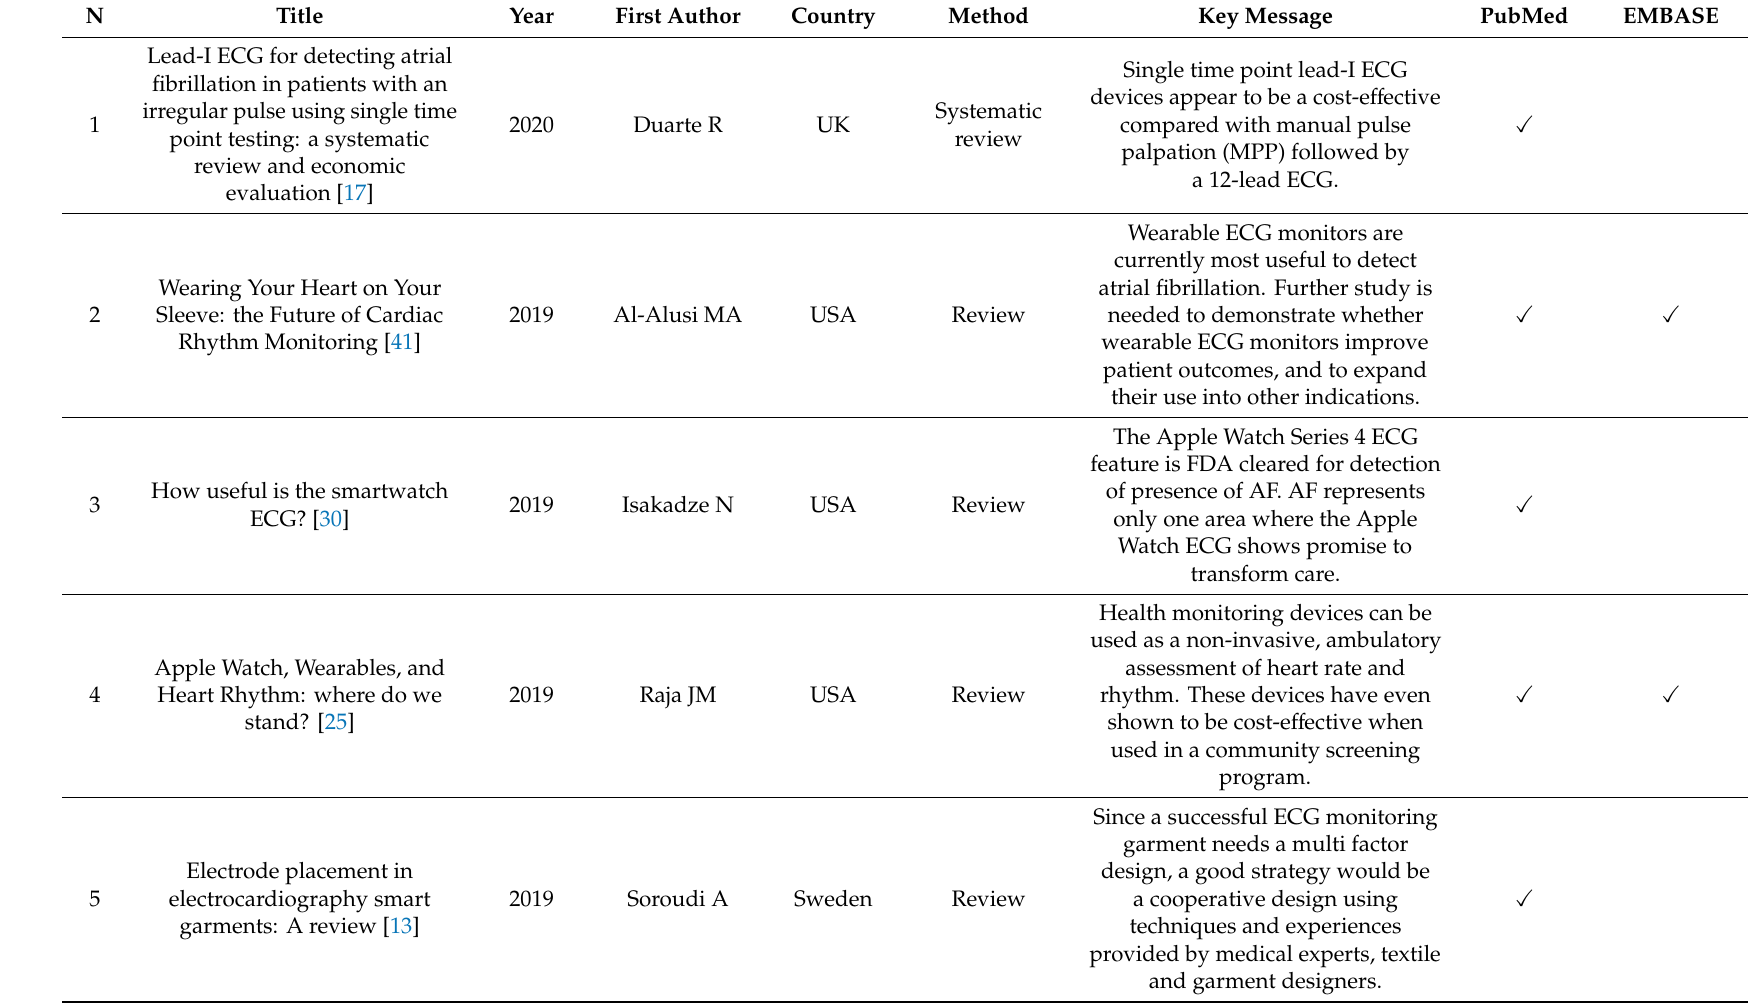
Table 1. Research strategy selected articles.